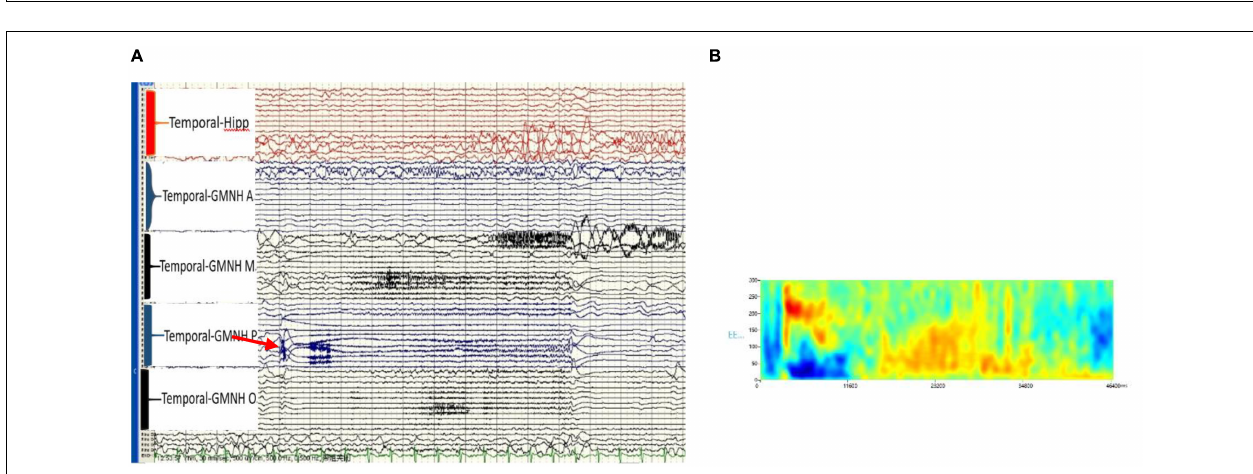
FIGURE 2 | (A) Pre-radiofrequency thermocoagulation (RFTC) 3D reconstruction MRI showing bilateral gray matter nodular heterotopia (GMNH), arrow. (B) Reconstruction of electrodes superimposed on GMNH.